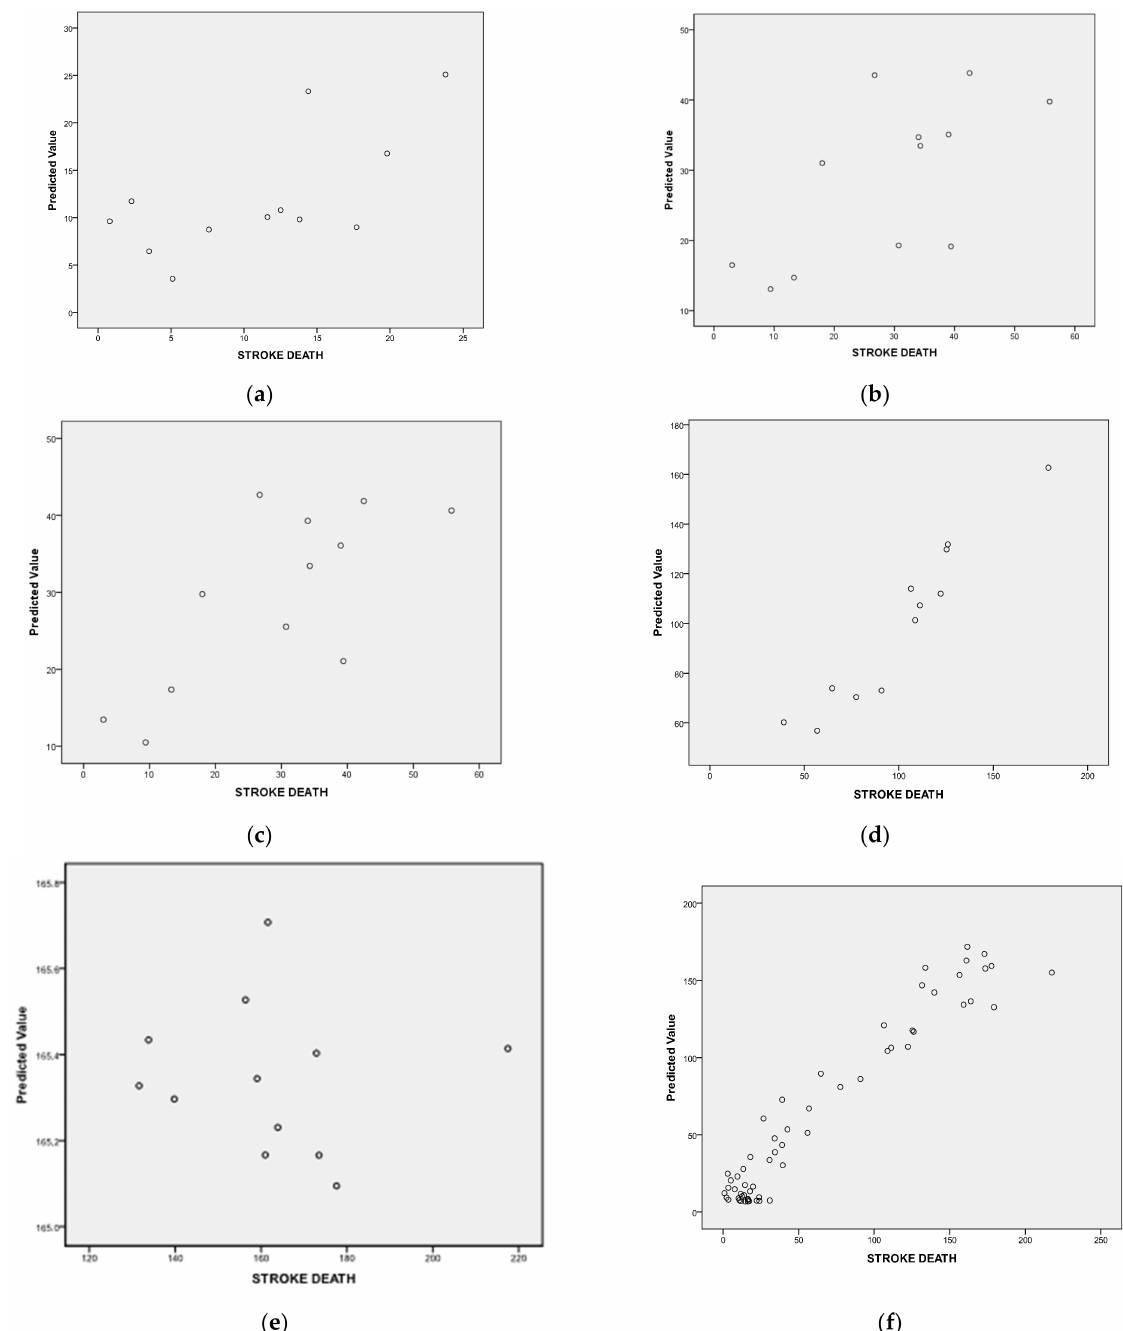
Figure 3. The scatter plots display the relation of predicted values by observed stroke deaths for: ( a ) 1985; ( b ) 1986; ( c ) 1987; ( d ) 1988; ( e ) 1989; ( f ) whole quinquennium. Thus, it is clear that the best results were predicted for 1985 and 1988, and the worst for 1989. Finally, in Table 2, the results for the importance of the correlated parameters TSI and EPOCH for every year, as well as in toto, are